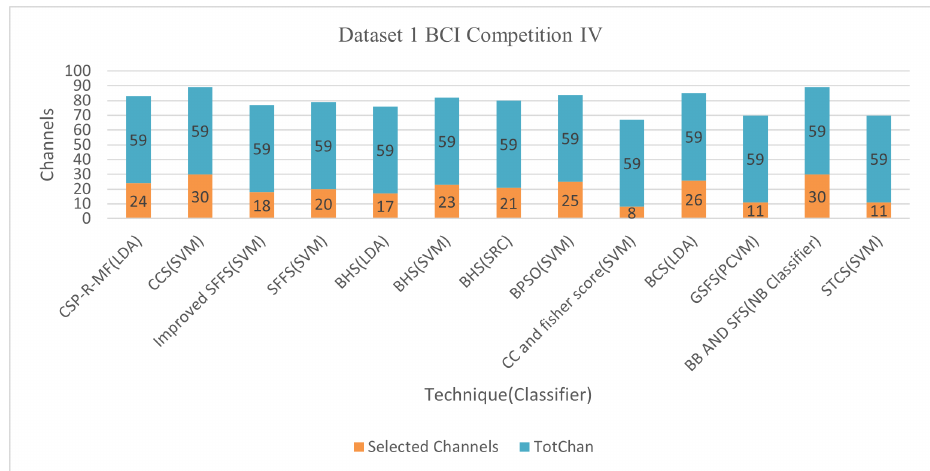
Figure 8. Selected channels by different techniques for Dataset I BCI Competition